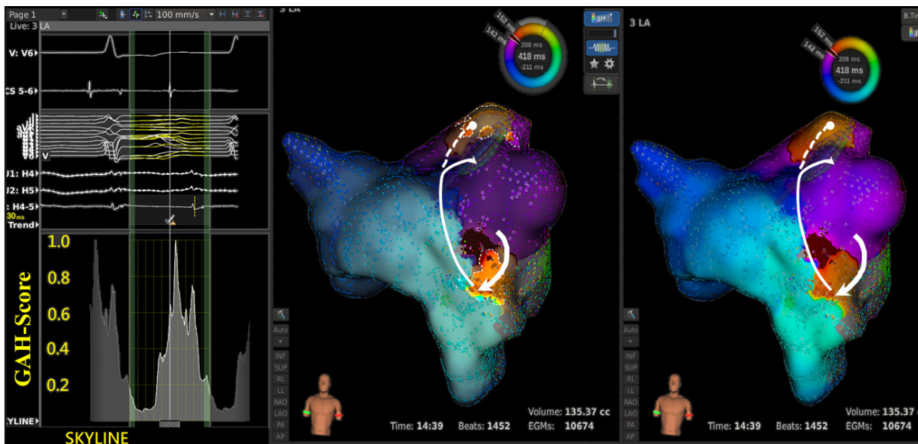
Figure 2. A case of localized reentry aAFL.